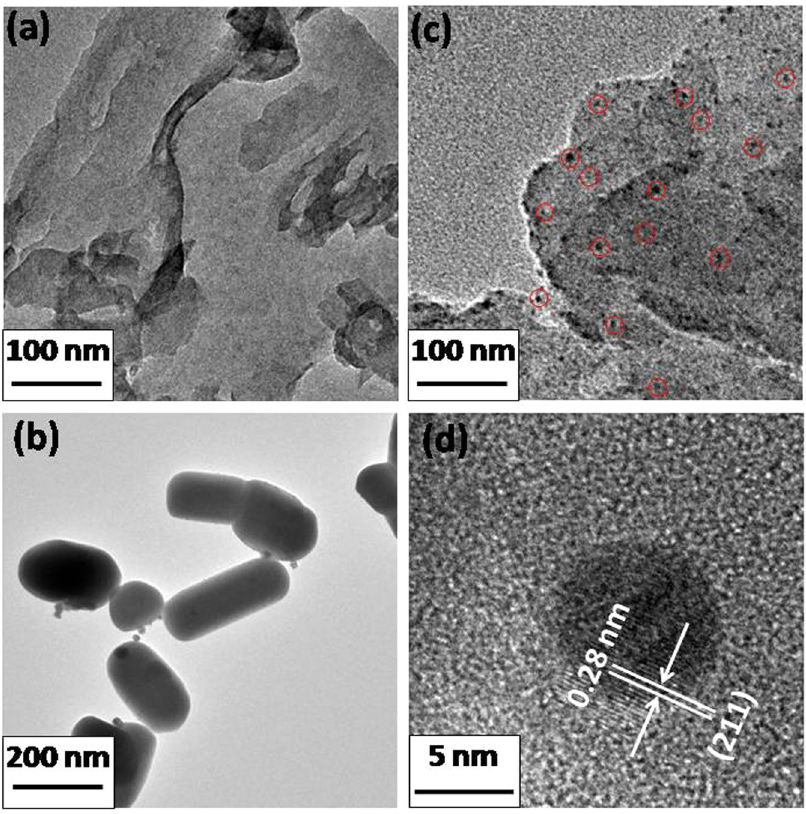
Figure 3. TEM images of ( a ) g-C 3 N 4 , ( b ) Ag 2 CrO 4 , ( c ) g-C 3 N 4 /Ag 2 CrO 4 (23.1%) (Ag 2 CrO 4 were labeled by red circles), ( d ) HRTEM of g-C 3 N 4 /Ag 2 CrO 4